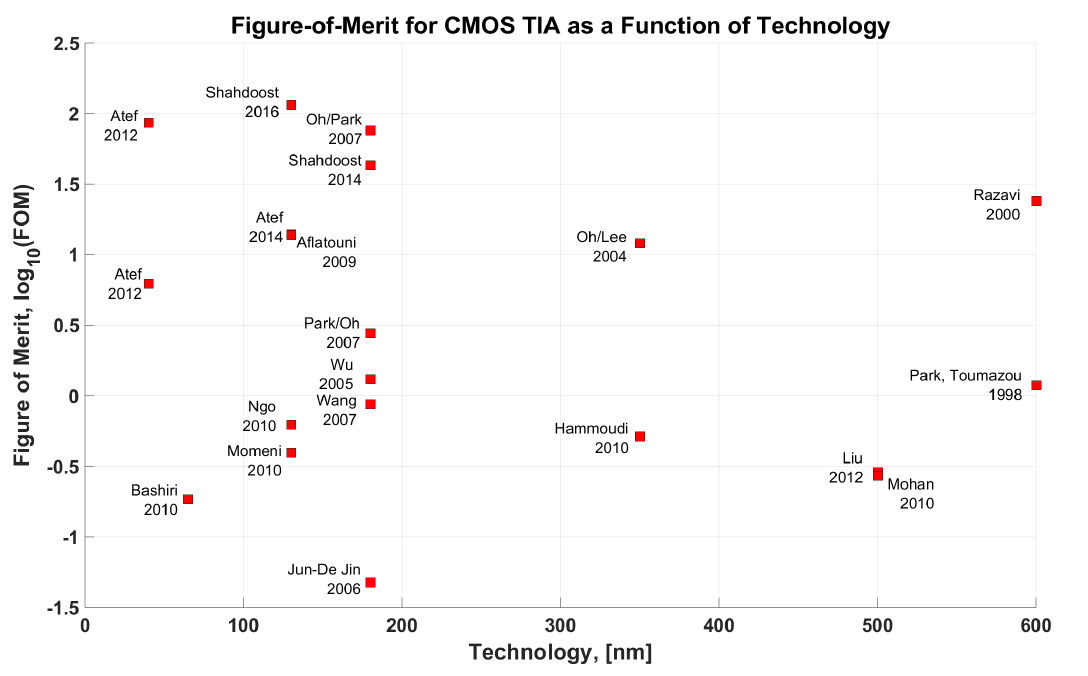
Figure 16. The FOM-based performance of the reported CMOS TIA depending on the